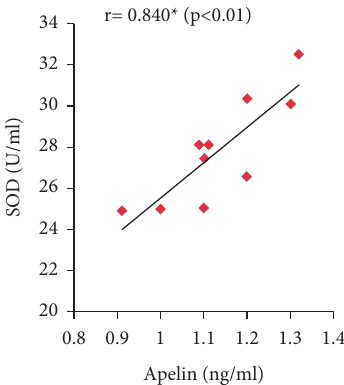
Figure 14: Correlation between serum apelin and SOD activity in the PE